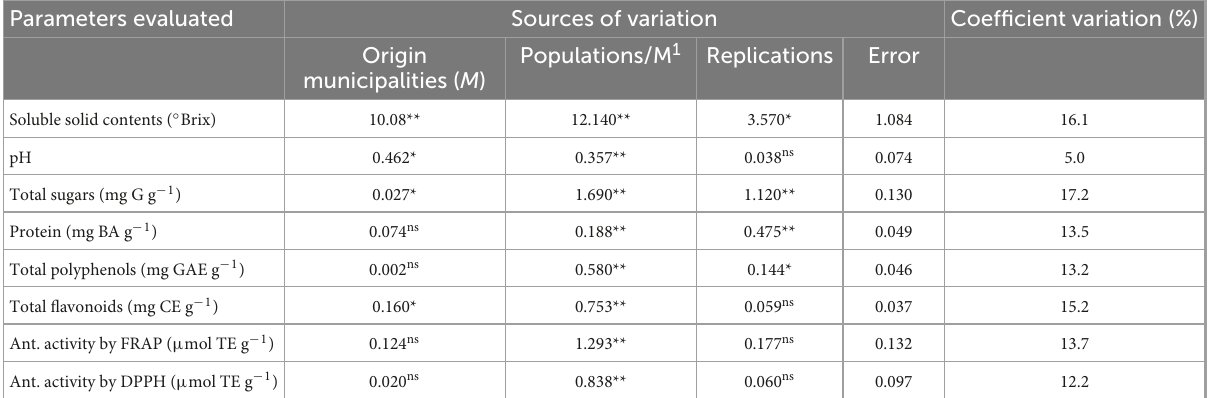
TABLE 1 Significance of square means of the analysis of variance of physicochemical parameters, phenolic compounds, and antioxidant activity in the pulp of C. ficifolia fruits. Parameters